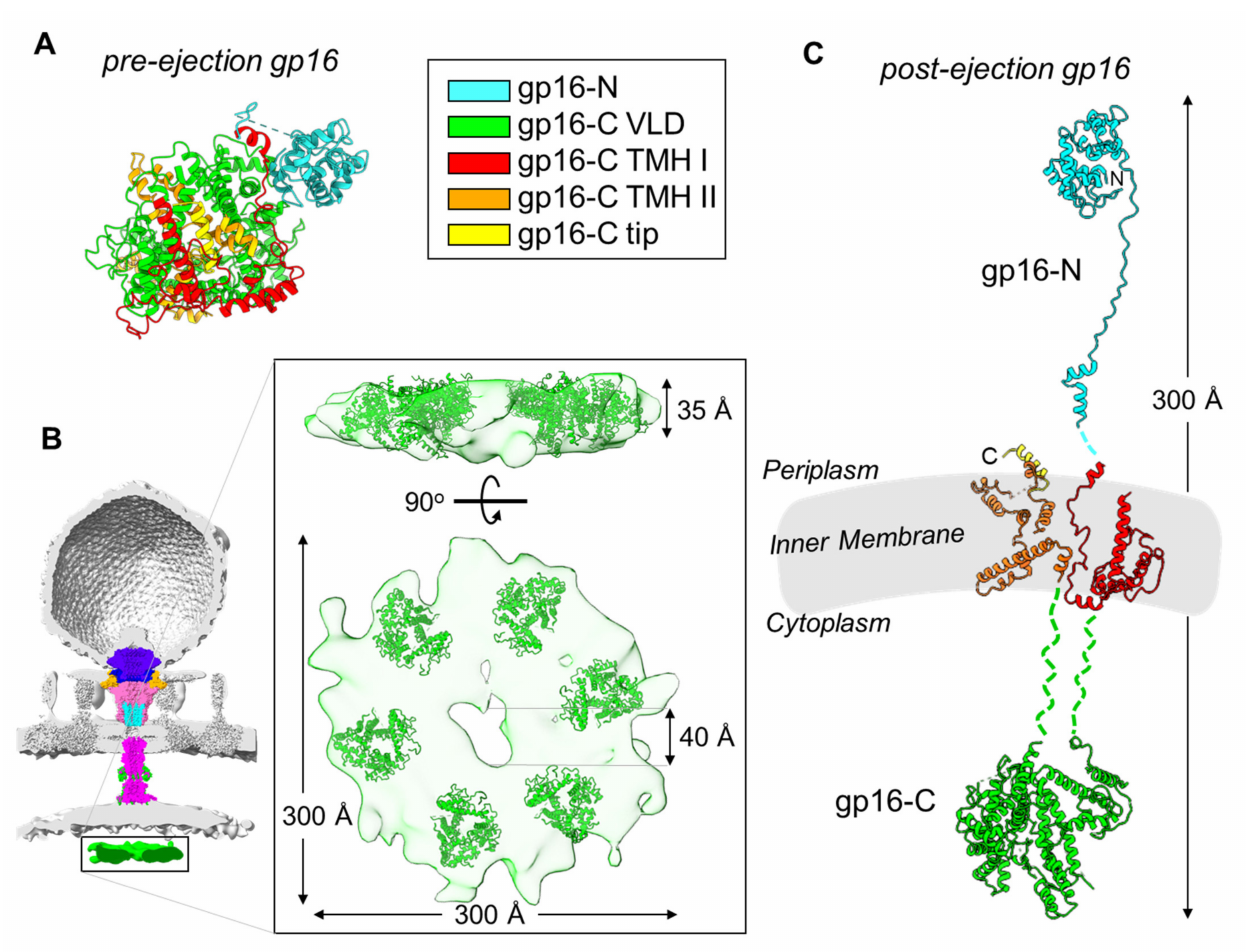
Figure 3. Modelling gp16 post-ejection. ( A ) Tertiary structure of gp16 in the pre-ejection conformation, color coded based on the mapped domains (PDB id 7EYB). ( B ) Six copies of gp16-C (residues 411- 1118; PDB id 7EYB) were fit inside the toroid density observed inside the host cytoplasm (colored in green; map EMD-5534). The density was exacted from the cryo-ET reconstruction shown as a semitransparent surface. ( C ) Composite model of gp16 tertiary structure in the post-ejection conformation, colored as in panel A. Only 16-N was experimentally observed. Length of post-ejection conformation gp16 estimated from cryo-ET reconstructions of T7 infecting E. coli minicells